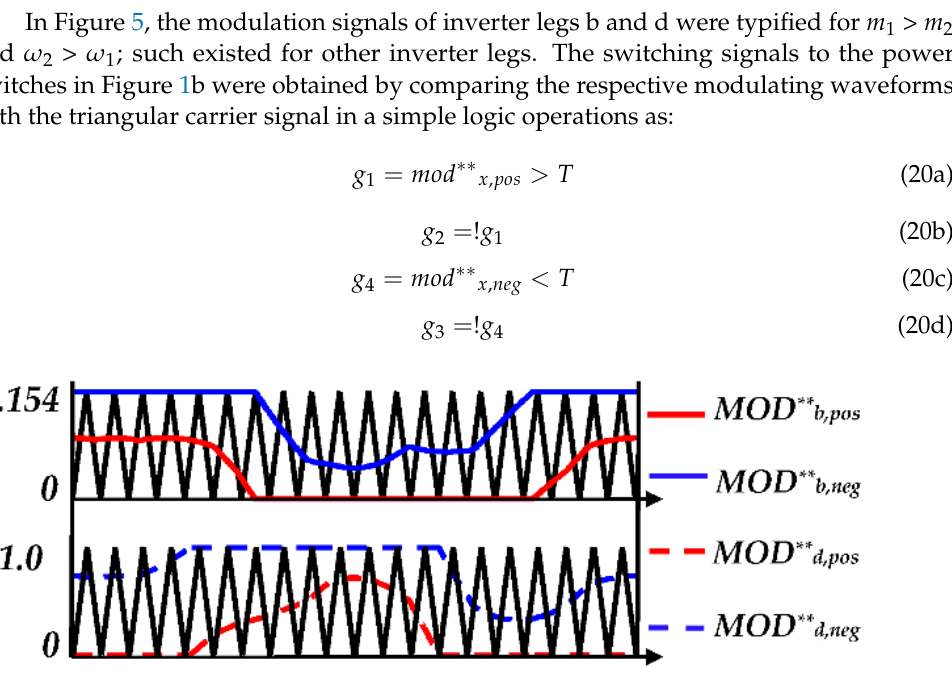
Figure 5. Typical modulating waveforms for inverter legs b and d for m 1 > m 2 and ω 2 > ω 1 . A flowchart that shows all the necessary steps for generating the gating signals of the inverter power switches is given in Figure